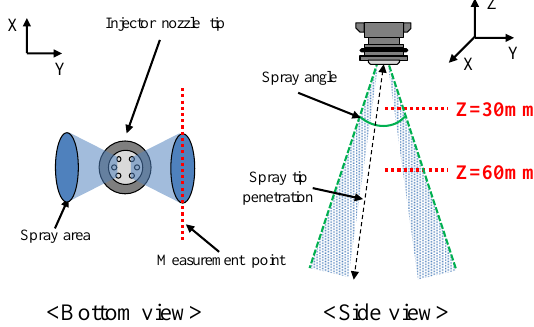
Figure 2. Definition of spray visualization experiment terminology and PDA experimental measurement area.